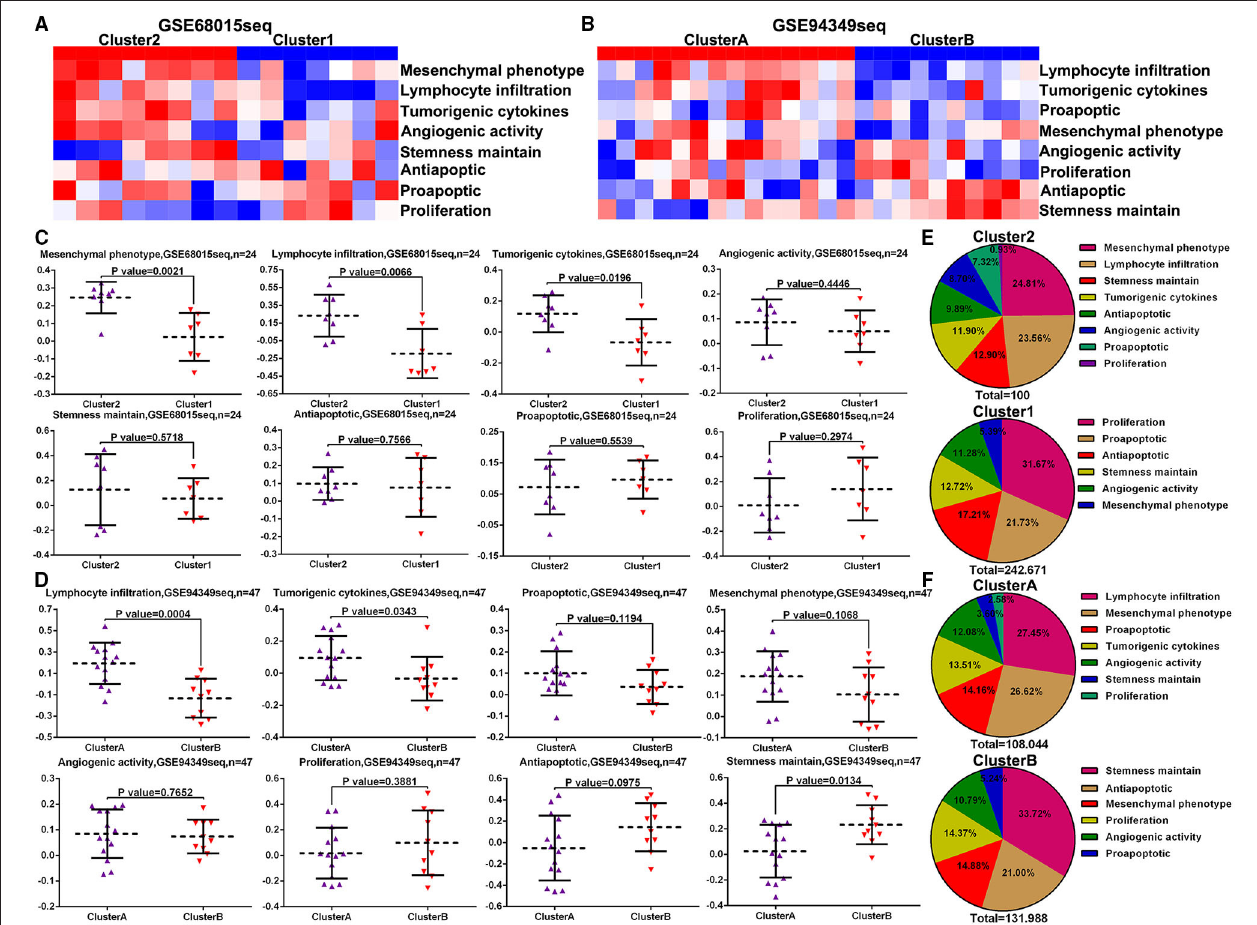
FIGURE 7 | ssGSVA between the IG and IR subtypes of ACPs. (A,B) Heat map displaying the distribution of eight biofunctions (proliferation, proapoptic, antiapoptic, stemness maintain, angiogenic activity, tumorigenic cytokines, lymphocyte infiltration, and mesenchymal phenotype) between cluster 1/2 and cluster A/B groups in the GSE68015 and GSE94349 databases. (C,D) The Scatter plot indicated the ratio differentiation of eight biofunctions among cluster 1/2, cluster A/B and normal pituitary groups. (E,F) Pie charts displayed the distribution of these biofunctions between cluster 1/2 and cluster A/B